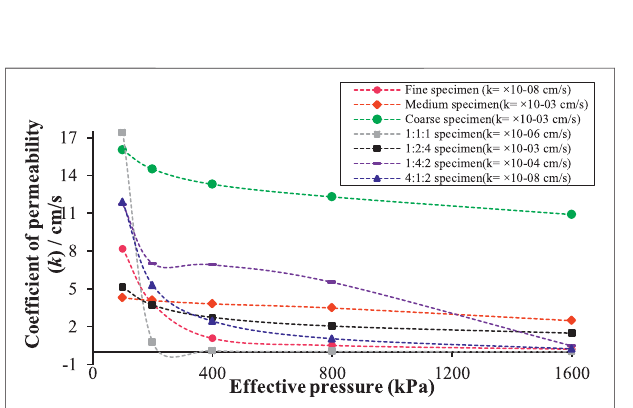
FIGURE 6 | Void ratio and porosity relationship with effective pressure. (A) Void ratio vs. effective pressure; (B) porosity vs. effective pressure.